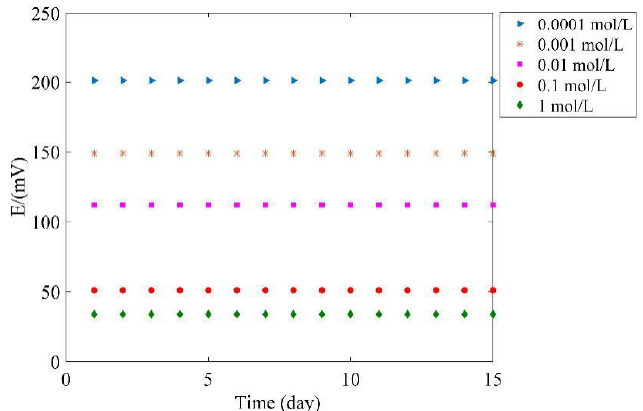
Figure 13. Long term stability.